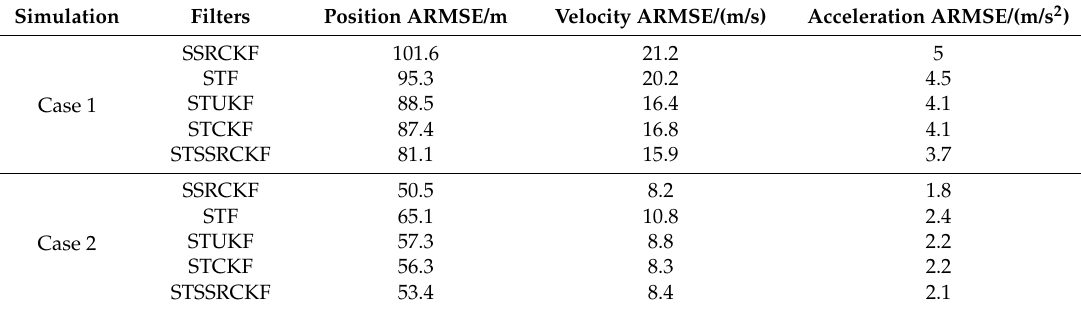
Table 3. ARMSEs in simulation of medium and weak maneuvering